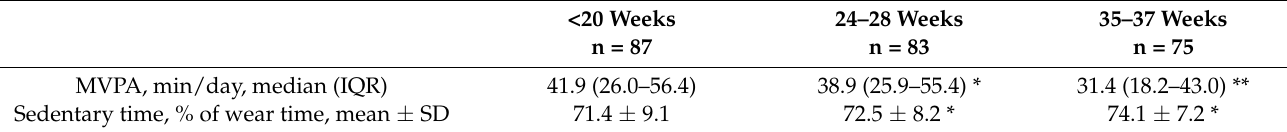
Table 2. Moderate-to-vigorous physical activity (MVPA) and sedentary time (ST) at three time points in pregnancy.